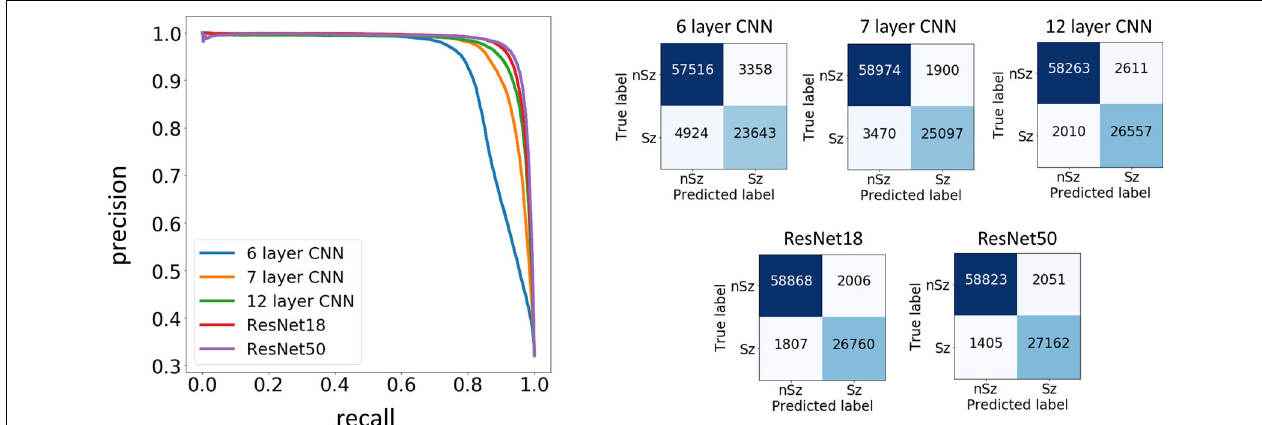
FIGURE 7 | Precision Recall curves and confusion matrices for one example data fold. The trained models assigned a seizure or non-seizure label to individual electrocorticographic (ECoG) channels, along with class prediction probabilities. The precision recall curves (left) show the precision or positive predictive value on the y -axis, and recall or model sensitivity on the x -axis for different thresholds of prediction probabilities, for each of the five model architectures trained in this study. The confusion matrices (right) show the number of ECoG channels of each classification (seizure and non-seizure) correctly and incorrectly predicted by the trained